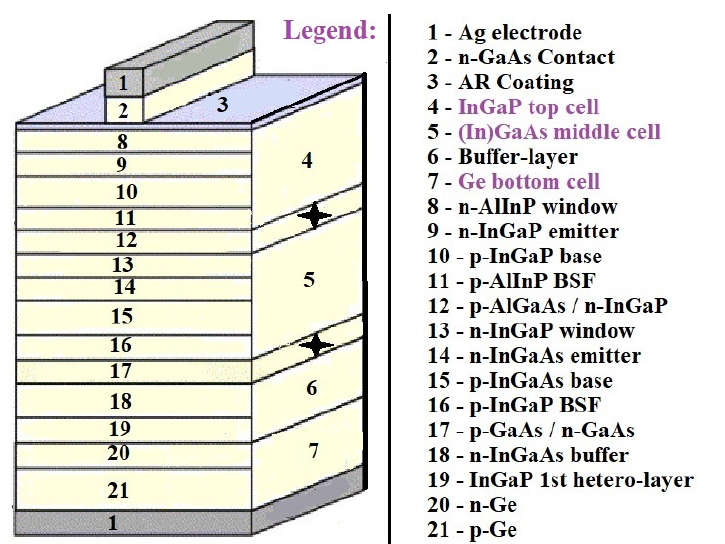
Figure 15. Schematic illustration of a triple-junction cell and approaches for improving efficiency of the cell [65].